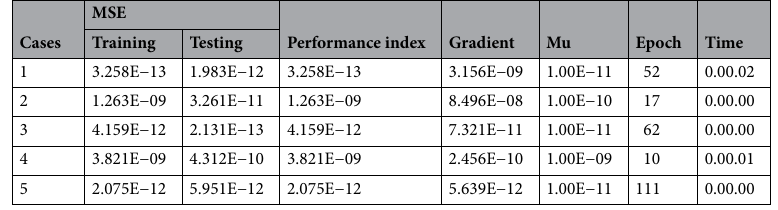
Table 5. Scenario 3: variation of ϕ .